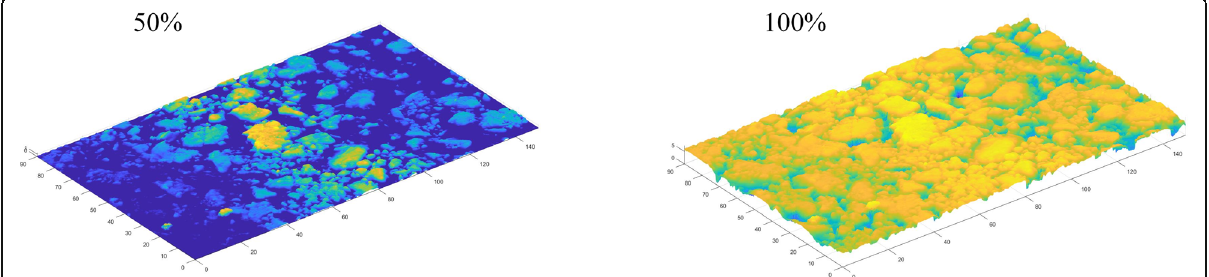
Fig. 3 An Example of Fractal Surface on Different Cutting